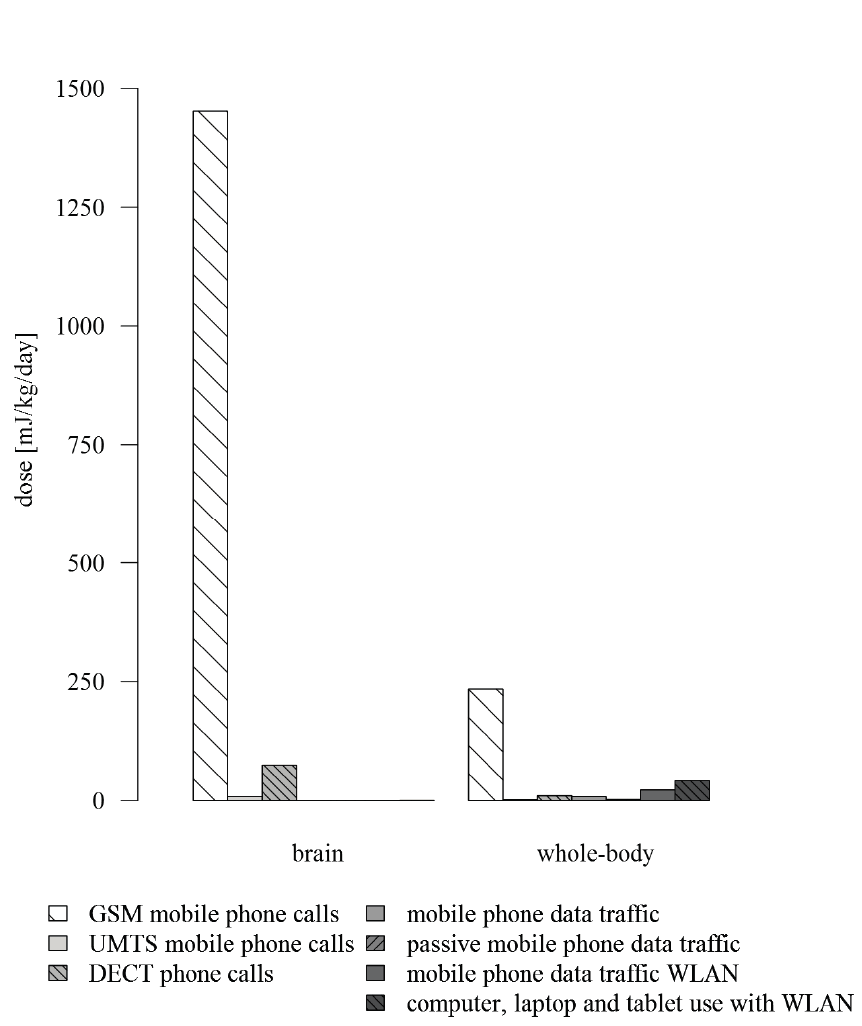
Figure 1. Mean daily cumulative brain (left) and whole-body (right) dose for the near-field